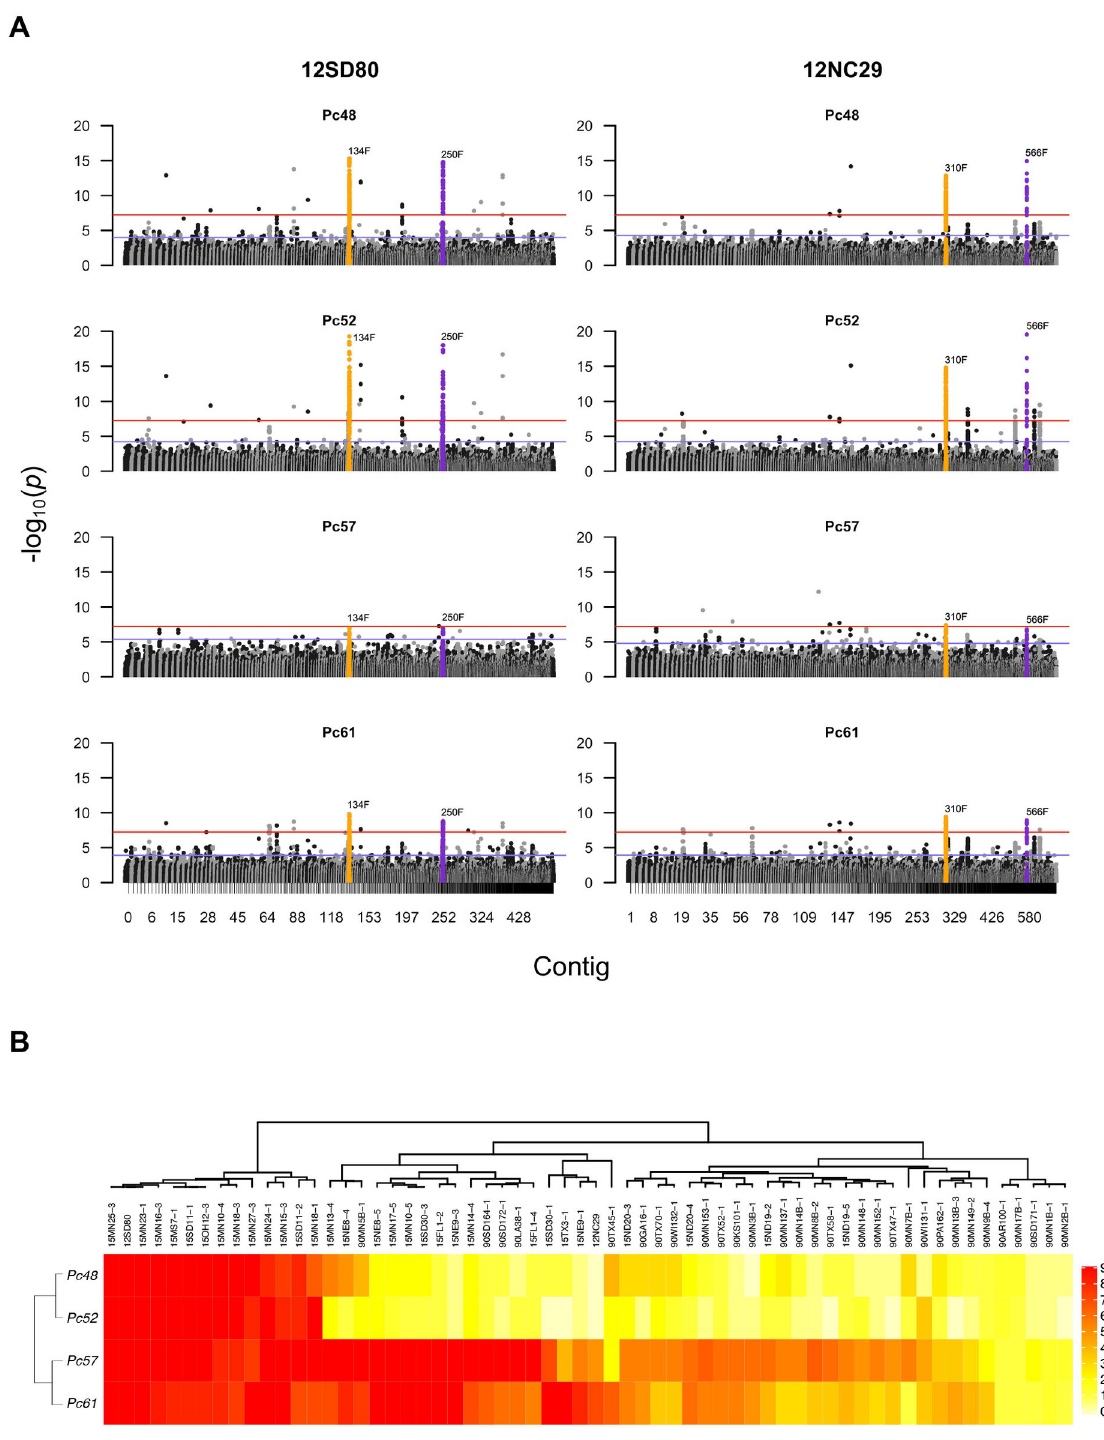
Fig 4. GWAS for virulence of Pca towards oat differential lines Pc48 , Pc52 , Pc57 , and Pc61 . (A) Manhattan plots showing SNP association values for virulence to Pc48 , Pc52 , Pc57 , and Pc61 across primary contigs in the 12SD80 (contig 134F and 250F) and 12NC29 (contigs 310F and 566F) genome assemblies. Highlighted SNPs in orange indicate contigs with significant association peaks and encoding predicted effector genes, whereas SNPs in purple represent significant contigs without any predicted effector genes. Red and blue horizontal lines denote Bonferroni significance threshold ( α = 0.05/total number of markers) and 5% false discovery rate threshold, respectively. (B) Heatmap showing virulence profiles of all isolates collected including 12SD80 and 12NC29 on Pc48 , Pc52 , Pc57 , and Pc61 . Infection scores were converted to a numeric scale (0 = resistance shown in yellow to 9 = susceptibility shown in red) for heatmap